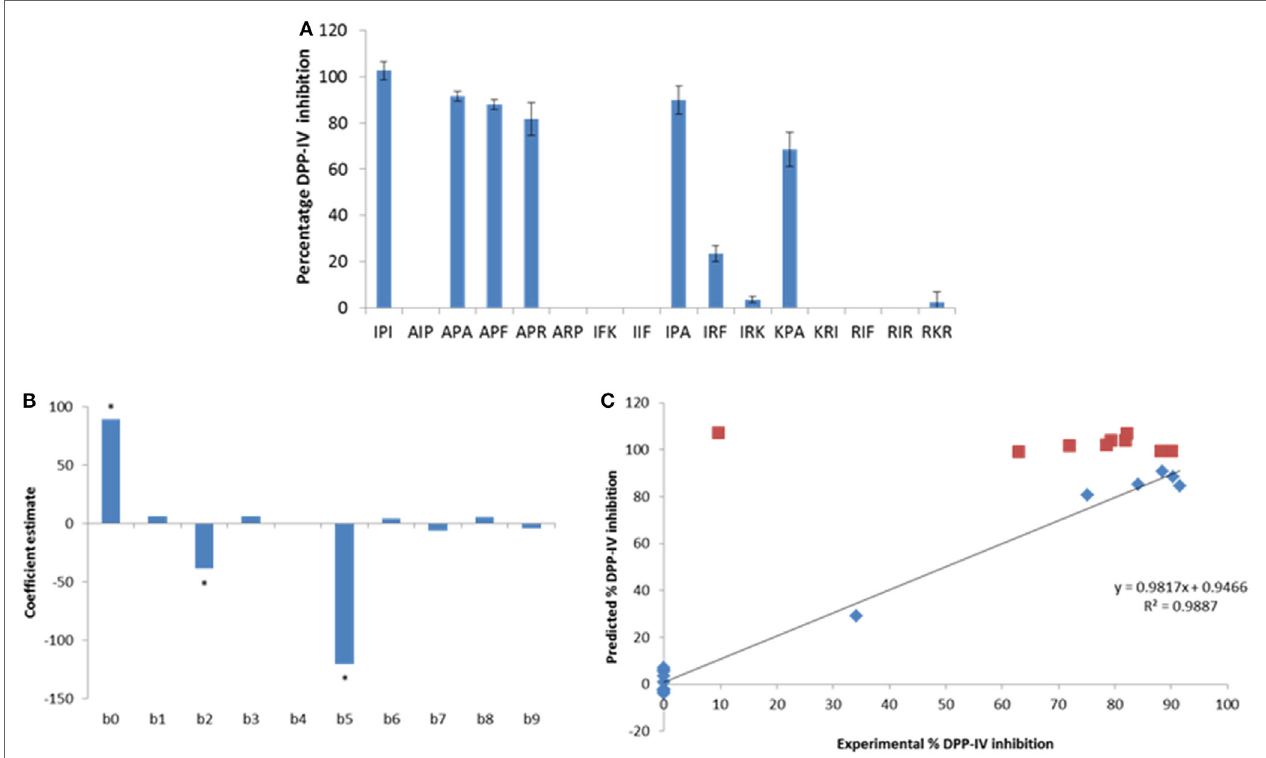
FigUre 2 | (a) Percentage of dipeptidyl peptidase IV (DPP-IV) inhibition observed with the peptides of the minimum analog peptide set evaluated at 500 µM. Values are mean ± SD ( n = 3). (b) Coefficients of the model ( β 0 – β 9 ; Eq. 2) linking the % DPP-IV inhibition of the peptides at 500 µM to their hydrophobicity ( v 3 ). (c) Predicted vs. experimental % DPP-IV inhibition of peptides from set #1 (diamonds) and set #2 (squares) evaluated at 500 µM. The line represents the multilinear regression model determined with data from peptide set #1 (Eq.